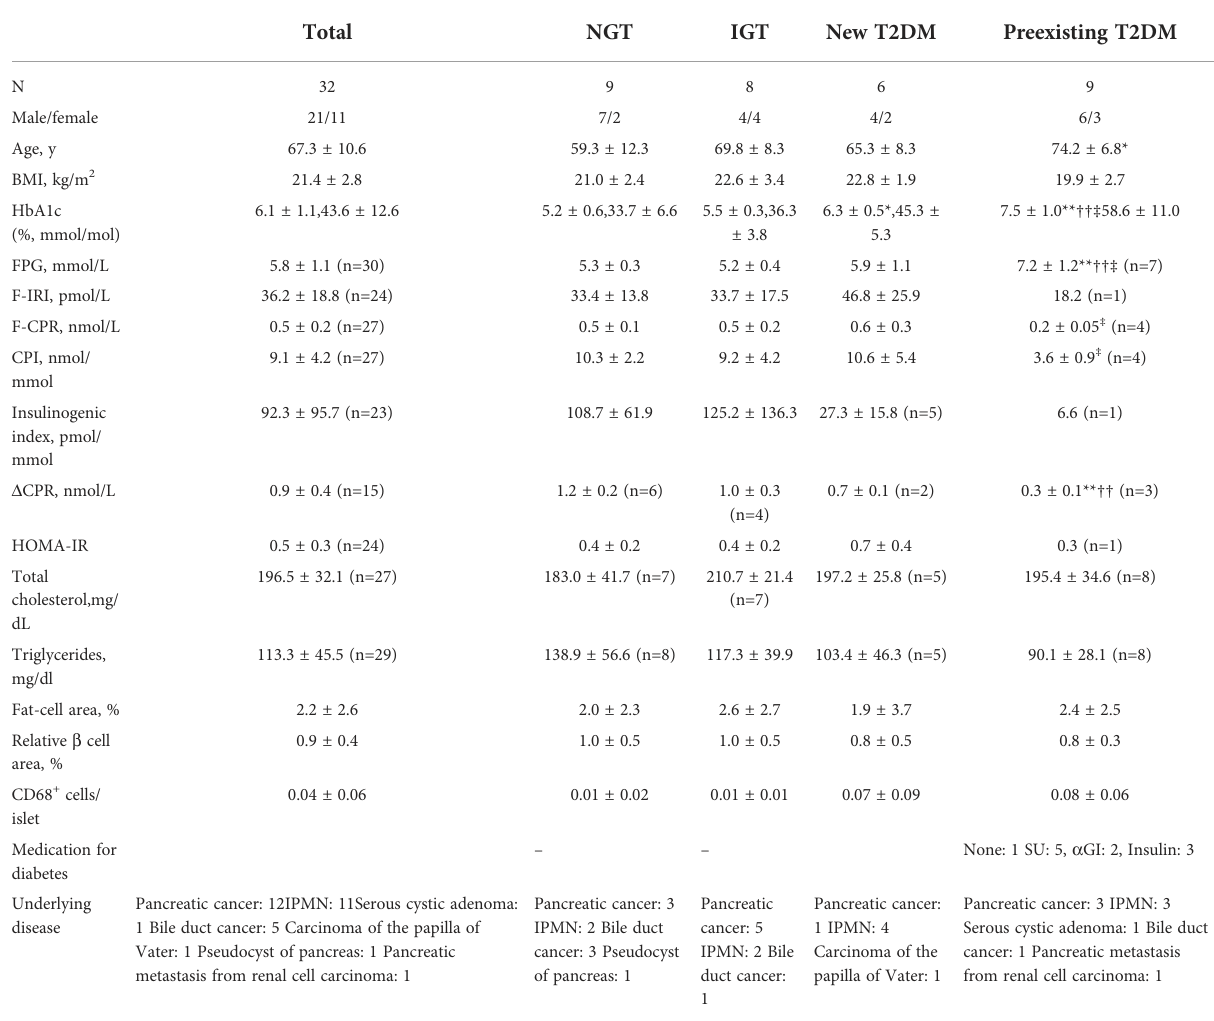
TABLE 1 Clinical Characteristics of 32